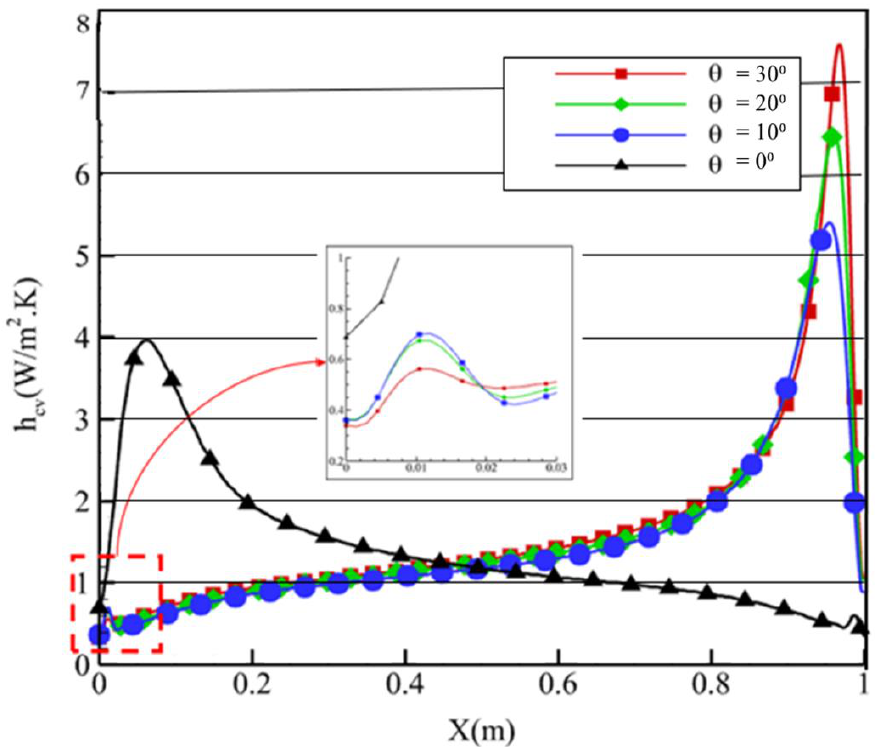
Figure 15. Local heat transfer coefficient for different angles at AR = 3.55.